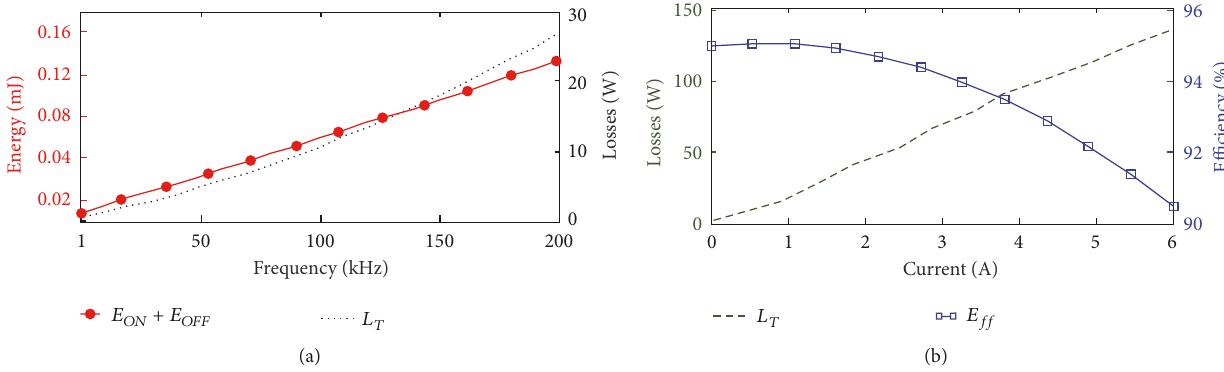
Figure 8: Energy and powerlosses evaluations.(a) Energyand powerlosses curvesinrelationtothefrequency.(b)Powerlosses and efficiency curves in relation to current in the